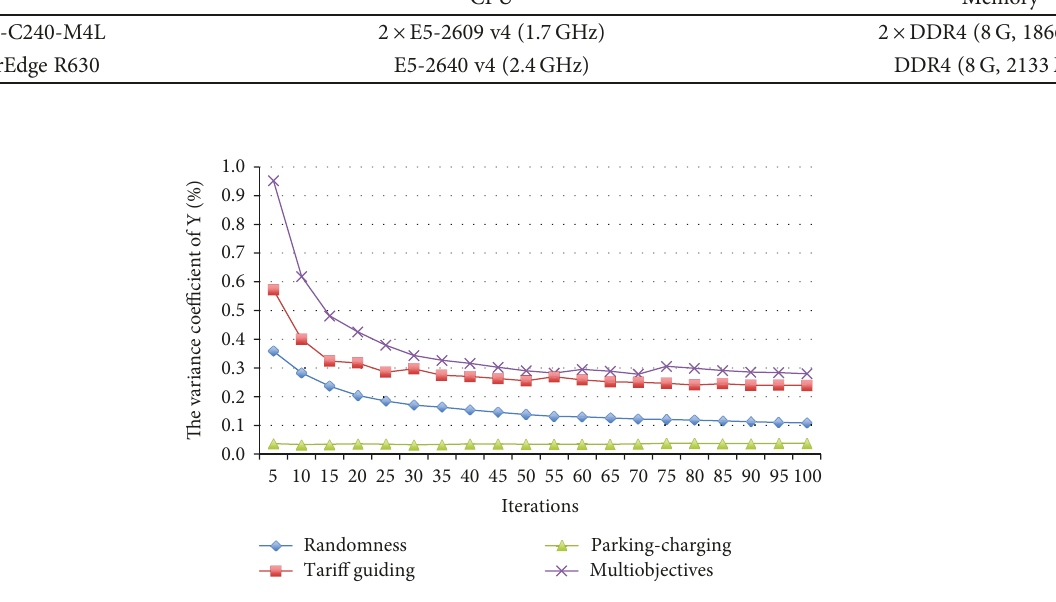
Figure 8: MC convergence under 4 di ff erent charging strategies.